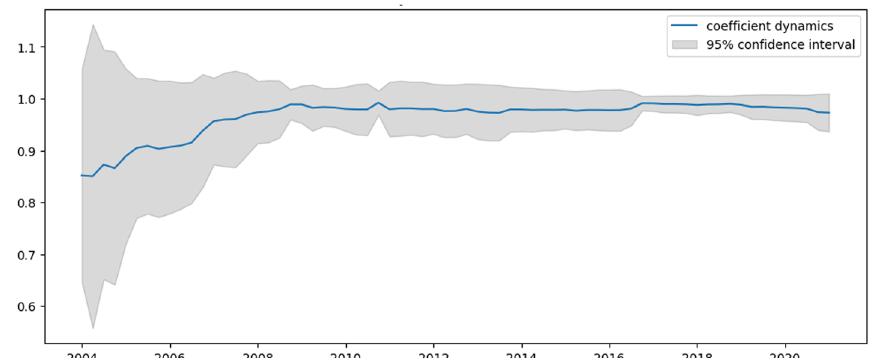
Fig. 8 β 1, t dynamics for Amazon